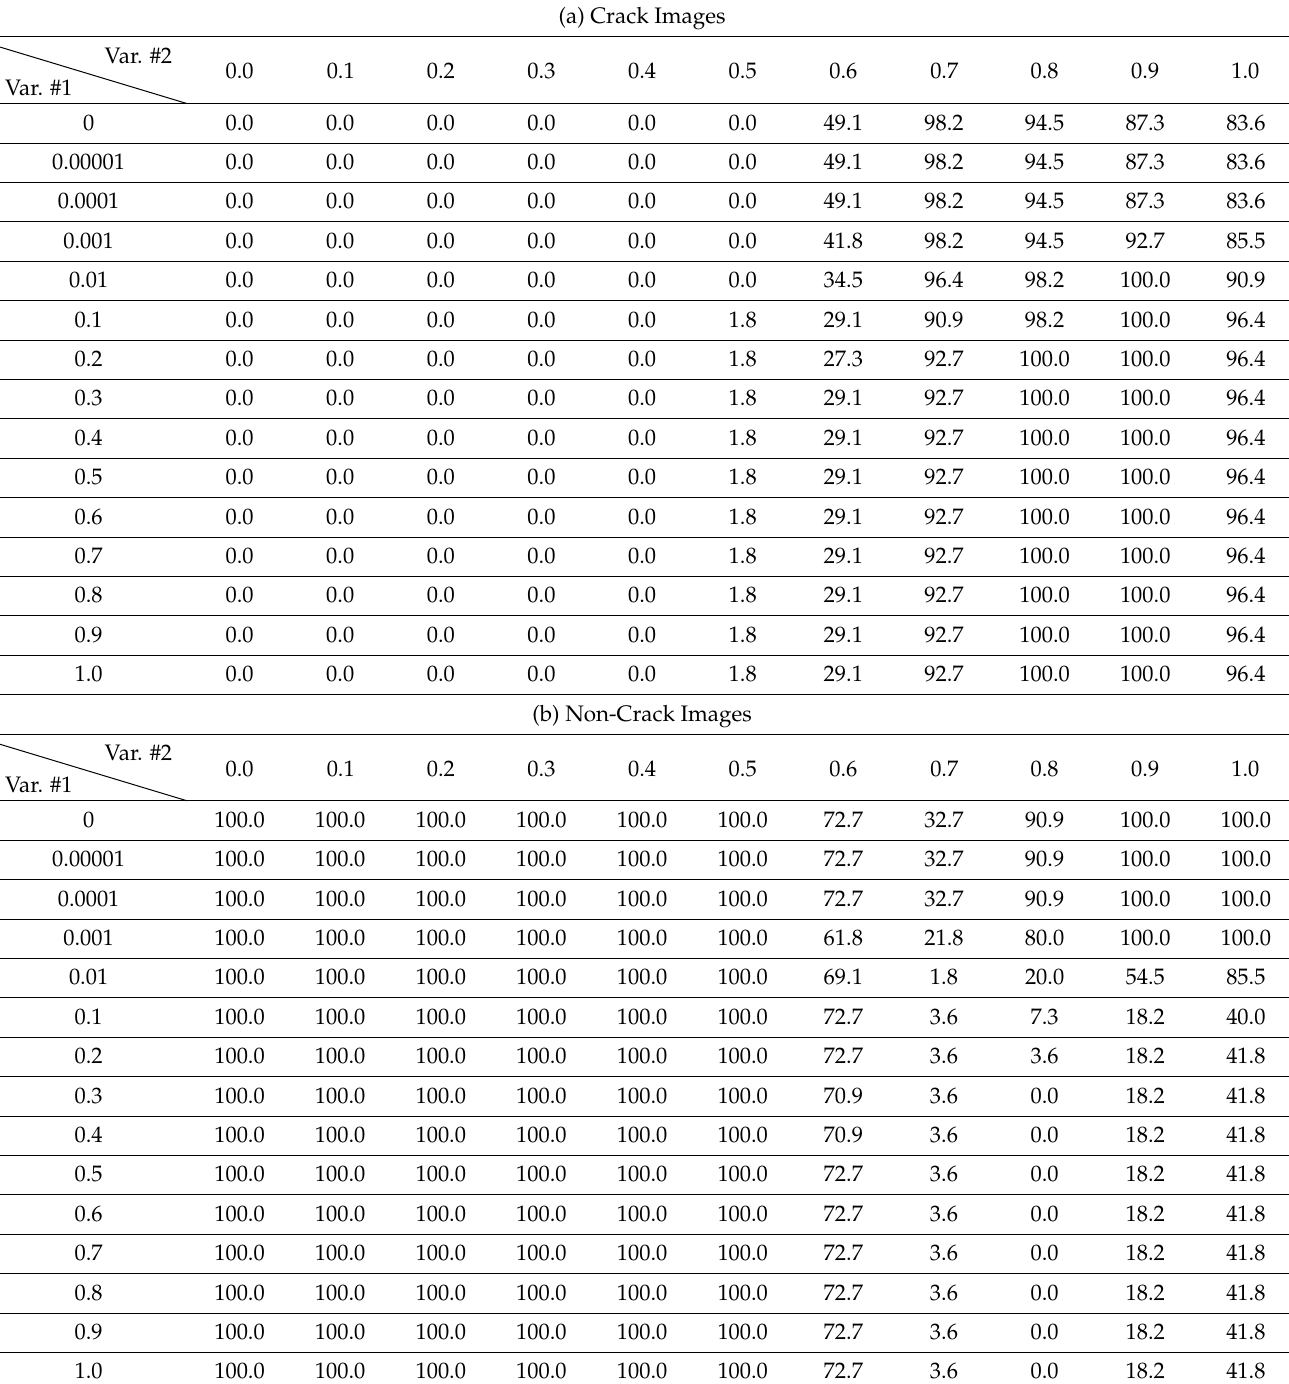
Table 5. Analysis results (%) by Var. #1 vs. Var. #2 (Var. #3: Median). (a) Crack